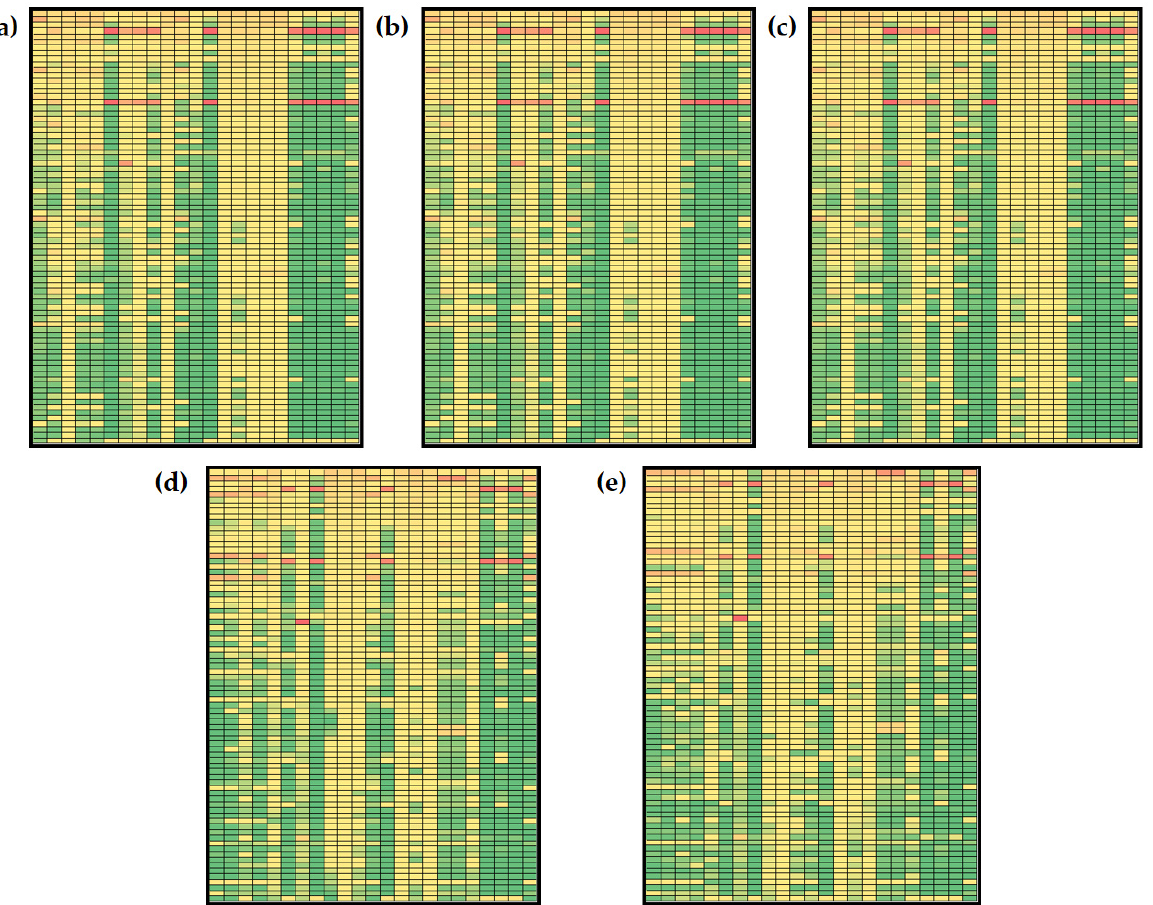
Figure 6. Global sensitivities of hepatic lipid model metabolites (initial conditions for simulations according to Menu 2): ( a ) t f = 10 min, ( b ) t f = 50 min, ( c ) t f = 100 min, ( d ) t f = 250 min, ( e ) t f = 500